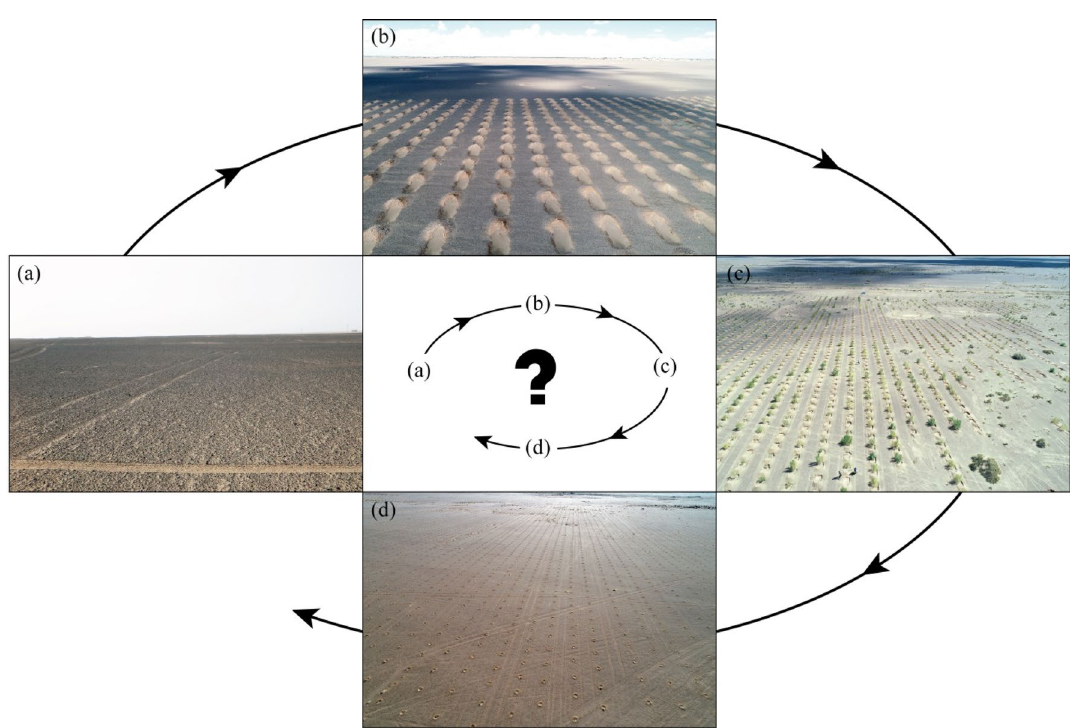
Figure 8. Diagram of different development stages of large-scale afforestation in the gobi region ( a : original ground surface; b : holes dug for afforestation; c the living trees planted; d : ground surface when the trees are